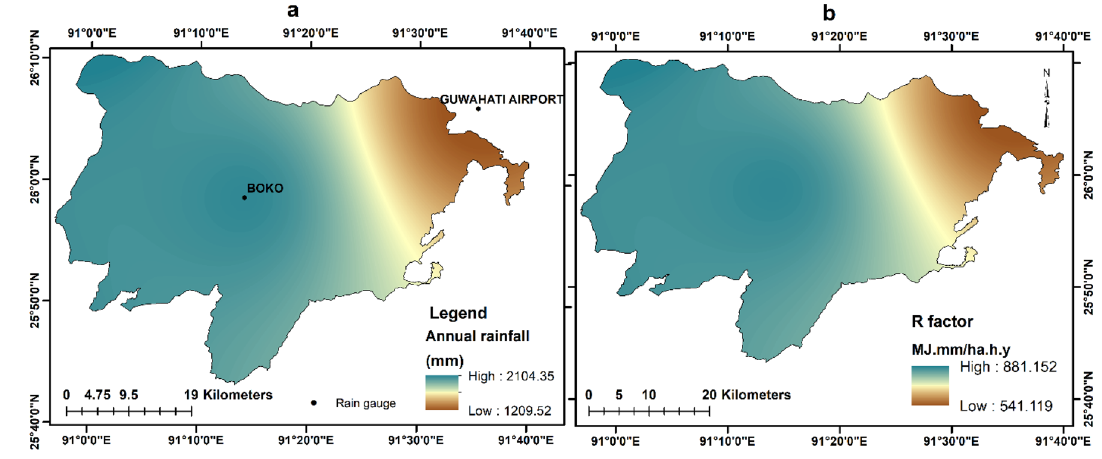
Fig. 2 a Spatial distribution of total annual rainfall in mm (2018), b R factor map of the lower Kulsi River